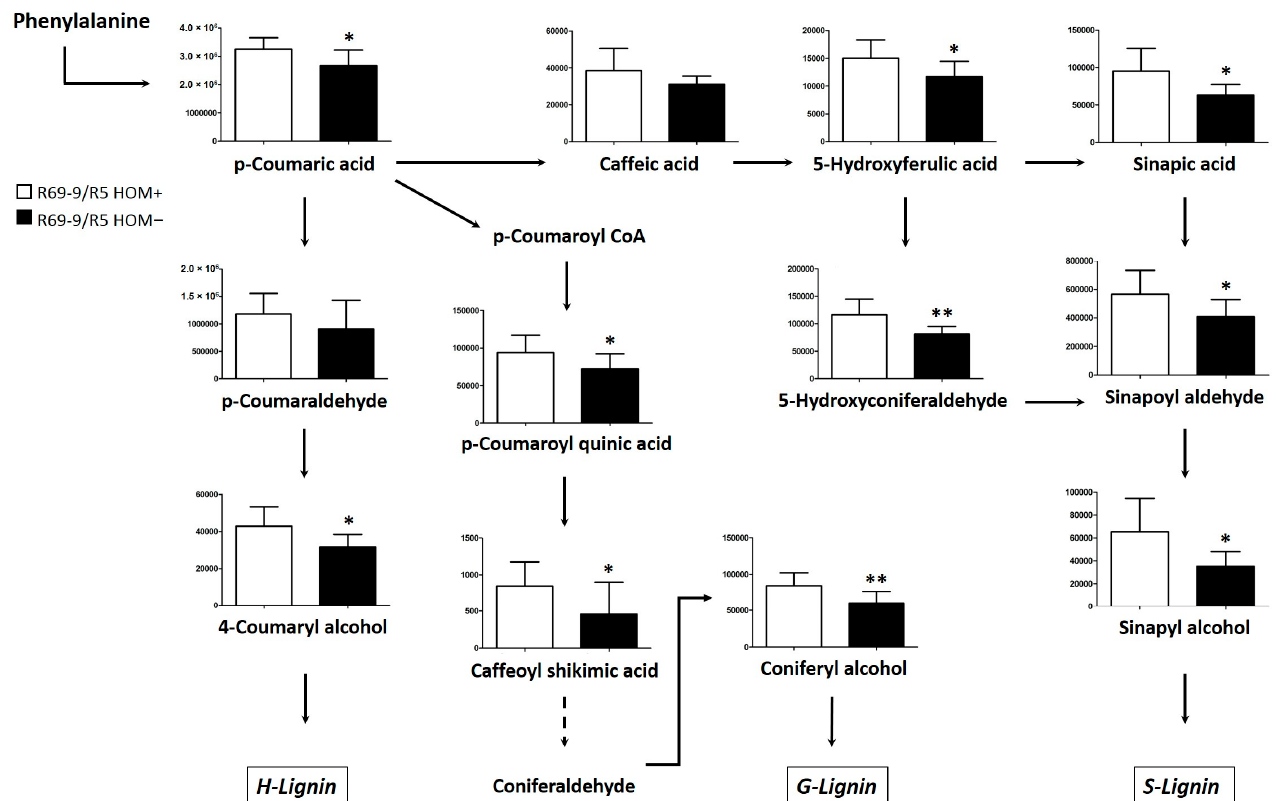
Figure 6. Significant changes in accumulation of intermediates of the phenylpropanoid biosynthetic pathway in the resistant Fhb7E (HOM+) vs. susceptible (HOM − ) lines at 4 dpi ( Fg ). Values on y-axes always indicate Peak intensity of a given metabolite, while bars on histograms represent standard deviations of means. Comparison for each metabolite between HOM+ and HOM − genotype was analysed using Student’s t -test; * and ** indicate p -values at <0.05 and <0.01 levels of signi fi cance, respectively. Solid arrows between metabolites indicate a direct transforming relationship, while the do tt ed arrow indicates an indirect process (more than one step).